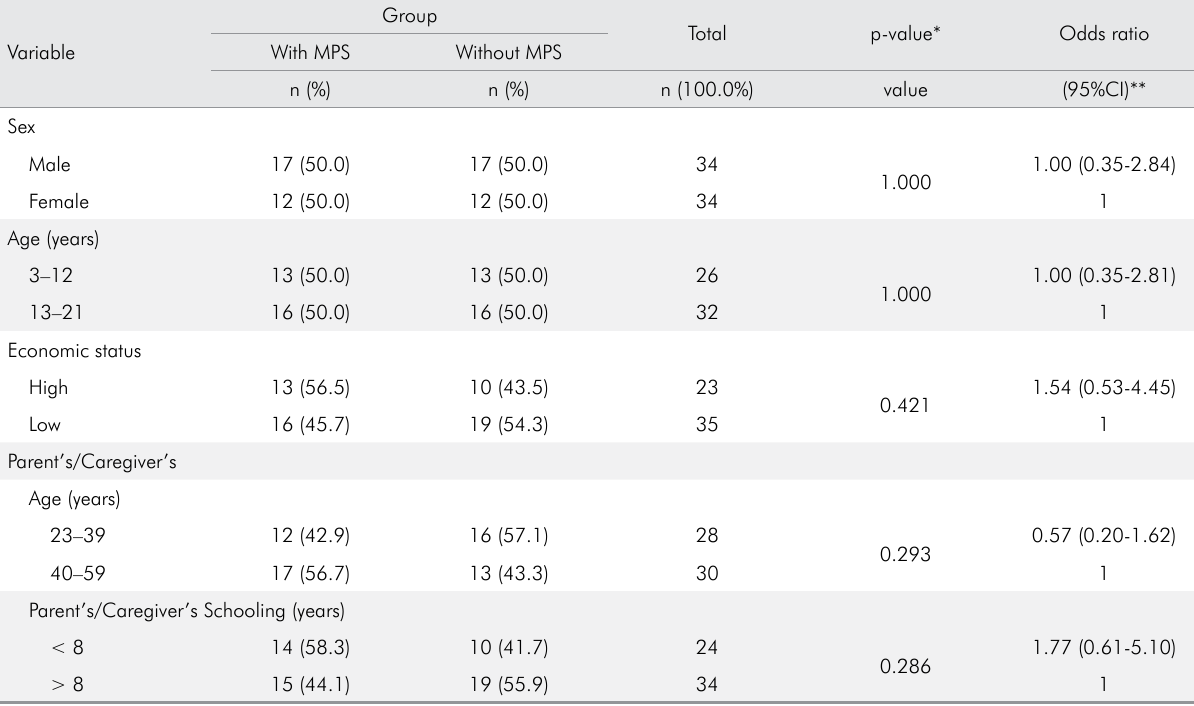
Table 1. Distribution of independent variables according to presence/absence of MPS (n = 58).